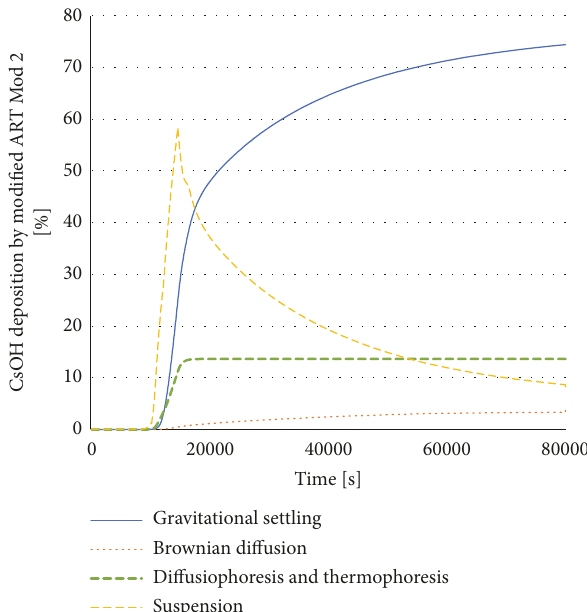
Figure 19: CsOH deposition from combination of calculations of all single volumes calculated by modified ART Mod